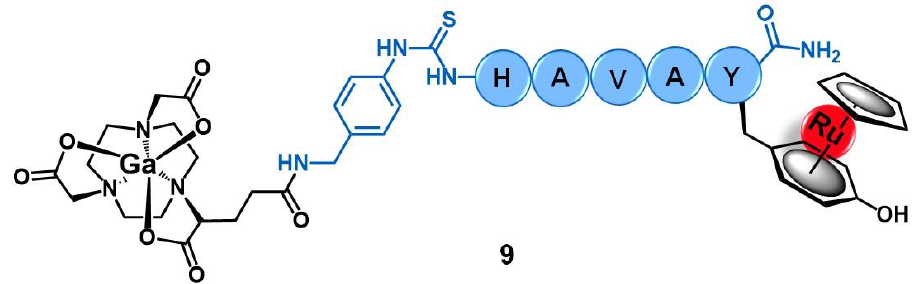
Figure 4. Ru(II)/Ga(III) heterobimetallic conjugate with the cadherin-targeting peptide HAVAY ( 9